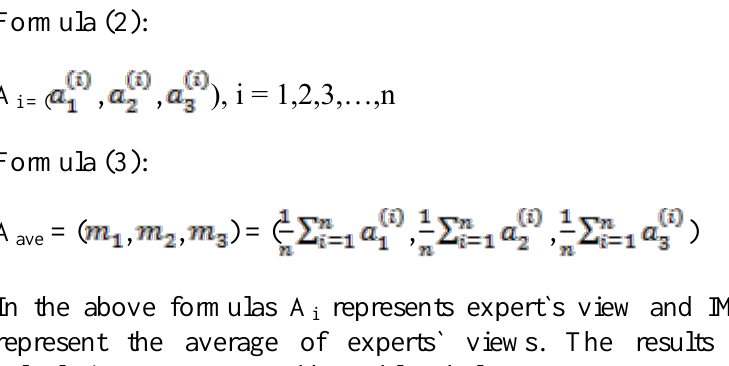
Table 3. Average of expert's points of view resulted from the first poll